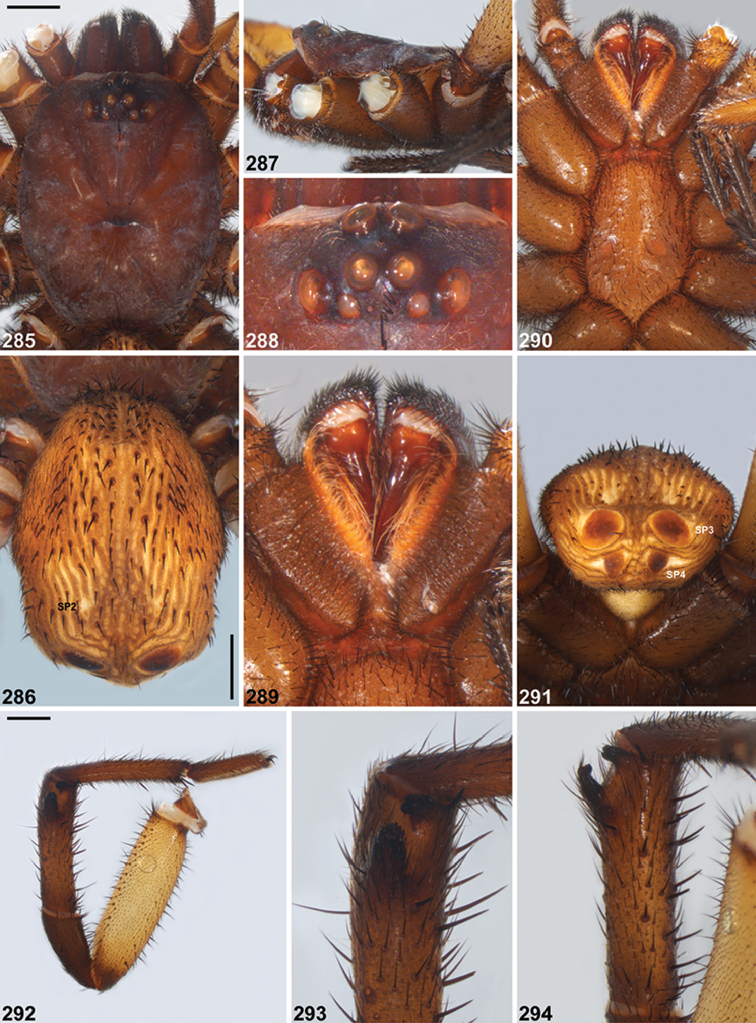

Idiosoma
mcclementsorum sp. n., male holotype (WAM T139471) from Julimar Conservation Park (Western Australia; JAF), somatic morphology. 285–286 Carapace and abdomen, dorsal view 287 Carapace, lateral view 288 Eyes, dorsal view 289 Mouthparts, ventral view 290 Sternum, ventral view 291 Abdomen, posterior view 292 Leg I, prolateral view 293 Leg I tibia, clasping spurs, prolateral view 294 Leg I tibia, proventral view. Scale bars 2.0. SP2–4 = sigilla pairs 2–4.